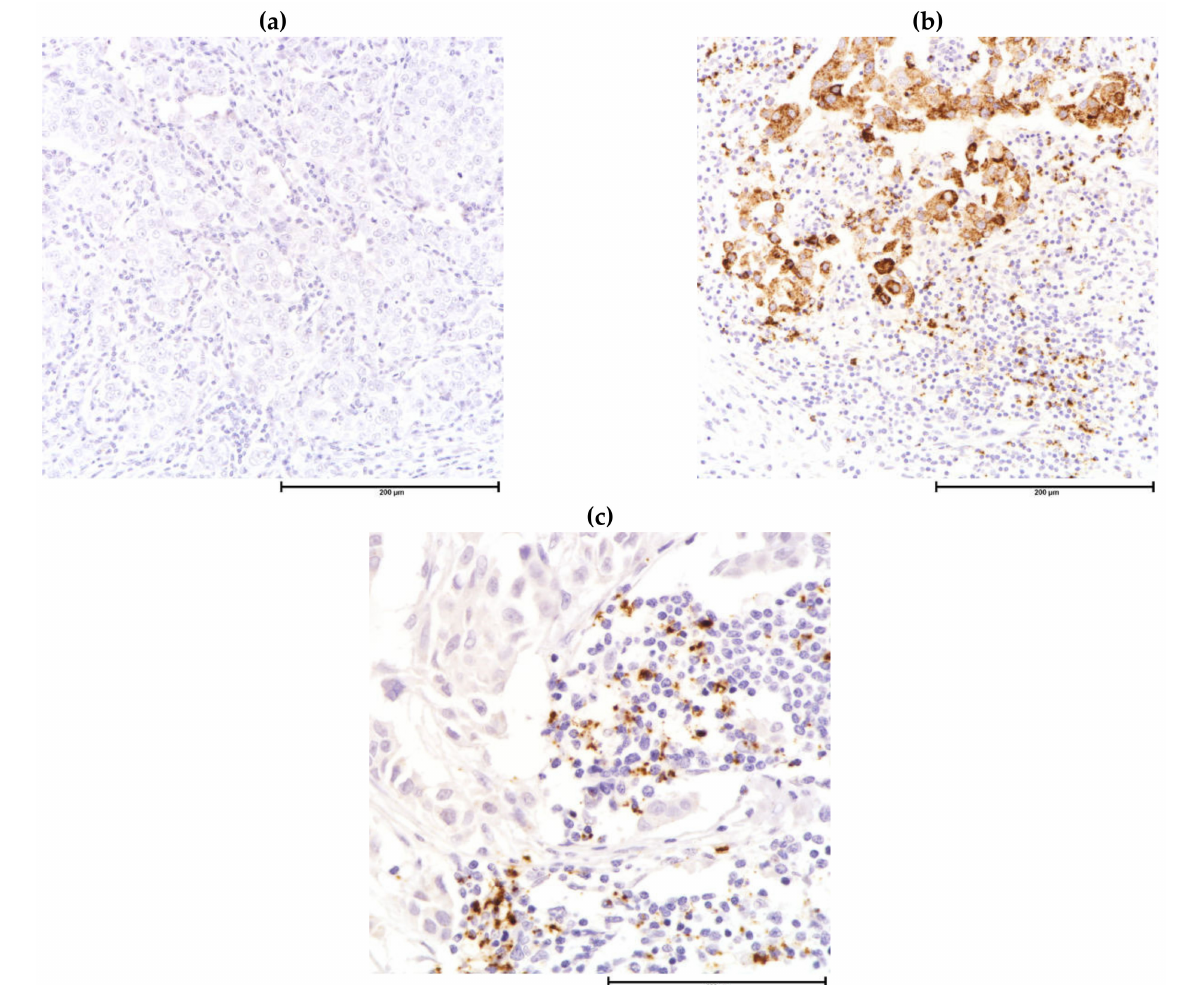
Figure 5. PD-L1 Immunohistochemistry. ( a ) Example of negative PD-L1 expression in tumor and immune cells, Ventana SP142, 200 × ; ( b ) Positive PD-L1 staining in tumor and immune cells, Ventana SP142, 200 × ; ( c ) Positive staining in immune cells only, Ventana SP142, 400 ×